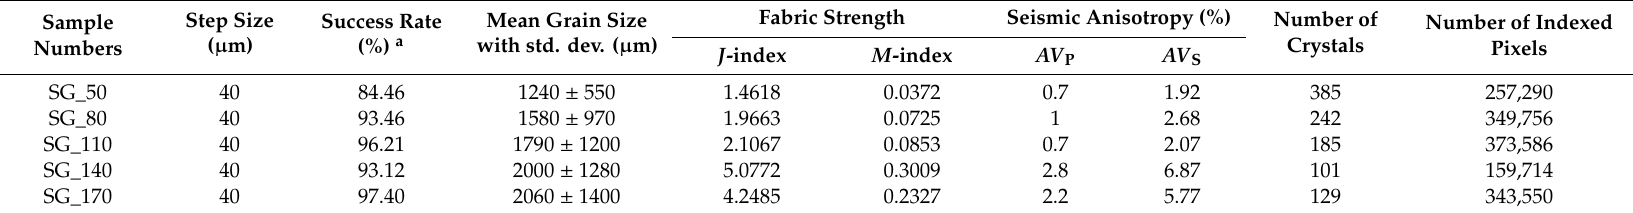
Table 2. Results of EBSD